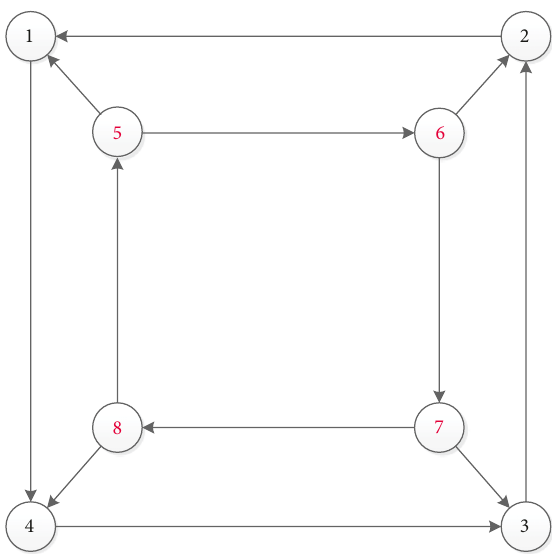
Figure 3: The positions of eight agents.